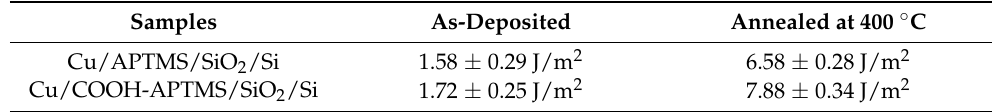
Table 1. Interface toughness of